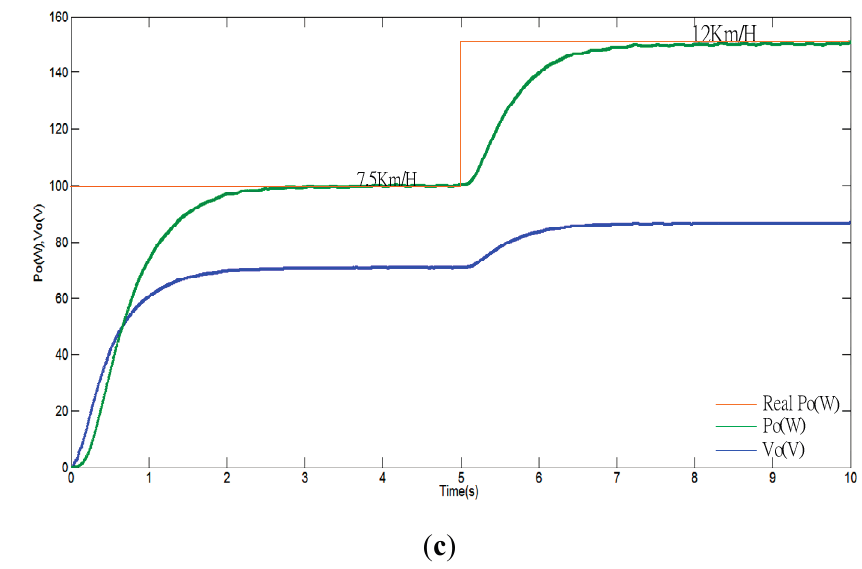
Figure 9. ( a ) P&O at a speed of 7.5 Km/H and 12 Km/H; ( b ) SMS at a speed of 7.5 Km/H and 12 Km/H; ( c ) ESMS at a speed of 7.5 Km/H and 12 Km/H.